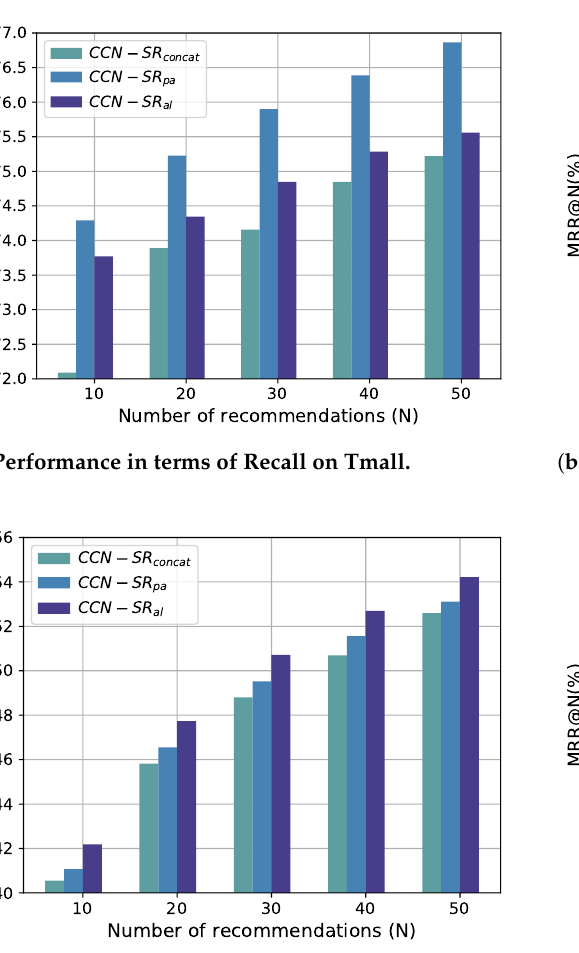
( c ) Performance in terms of Recall on Tianchi. ( d ) Performance in terms of MRR on Tianchi. Figure 4. Performance of CCN-SR with different strategies combining structural as well as sequential information on the top N recommendation task, tested on the Tmall and Tianchi